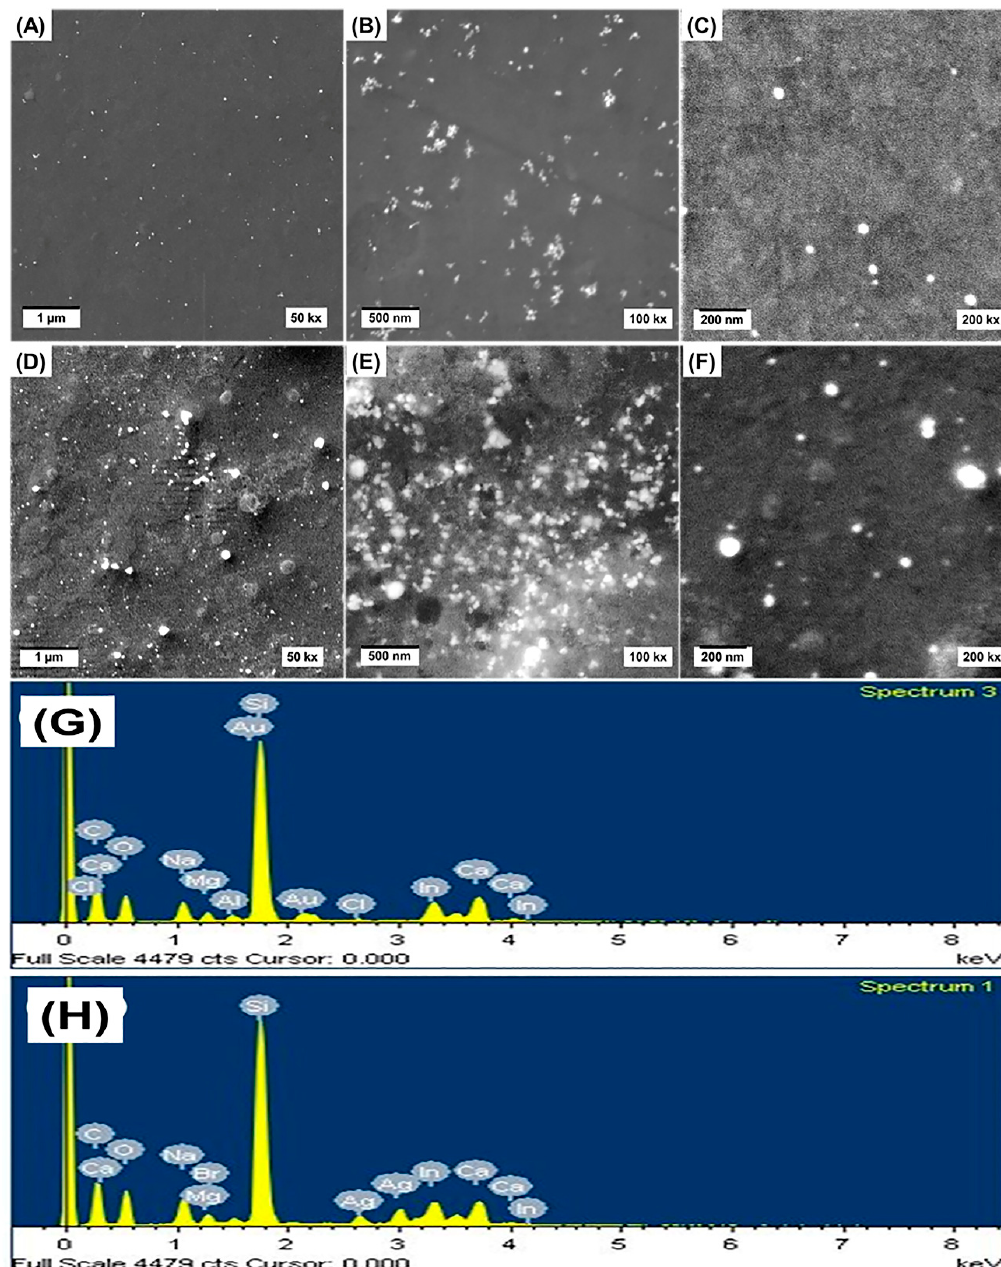
Figure 3. FESEM image of tuber mediated synthesized AuNPs and AgNPs. ( A , B ) low magnification and ( C ) high magnification FESEM images of AuNPs. ( D , E ) low magnification and ( F ) high magnification FESEM images of AuNPs. EDS of ( G ) AuNPs and ( H ) AgNPs.